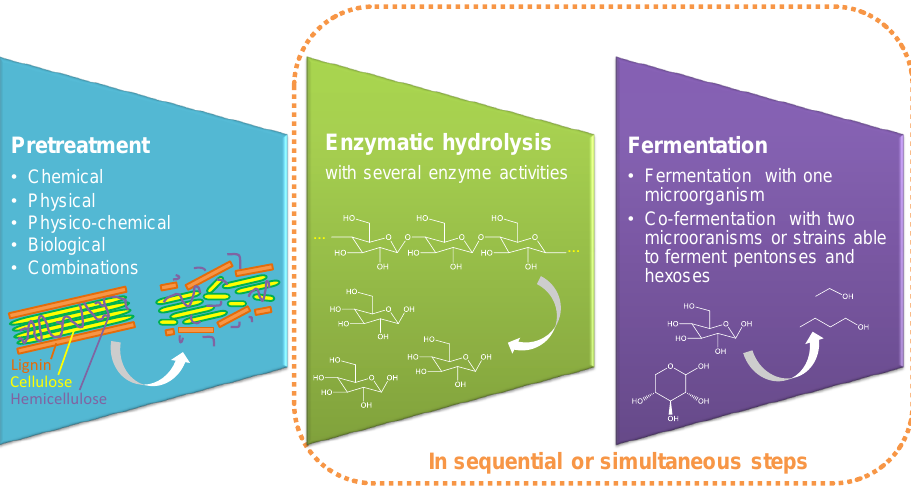
Figure 7. Summary of the steps followed to produce liquid biofuels.